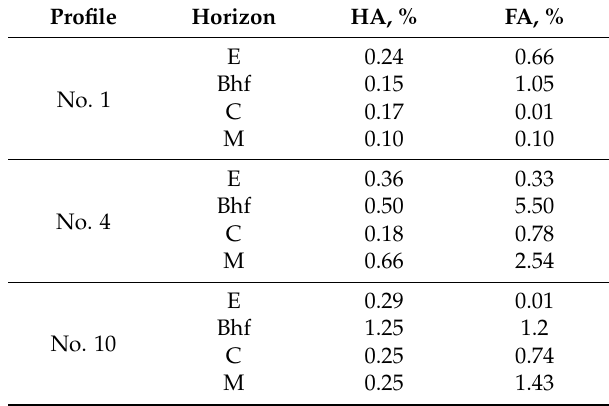
Table 9. Concentration of HA and FA carbon in surface sediments in the Piilola prospecting area.